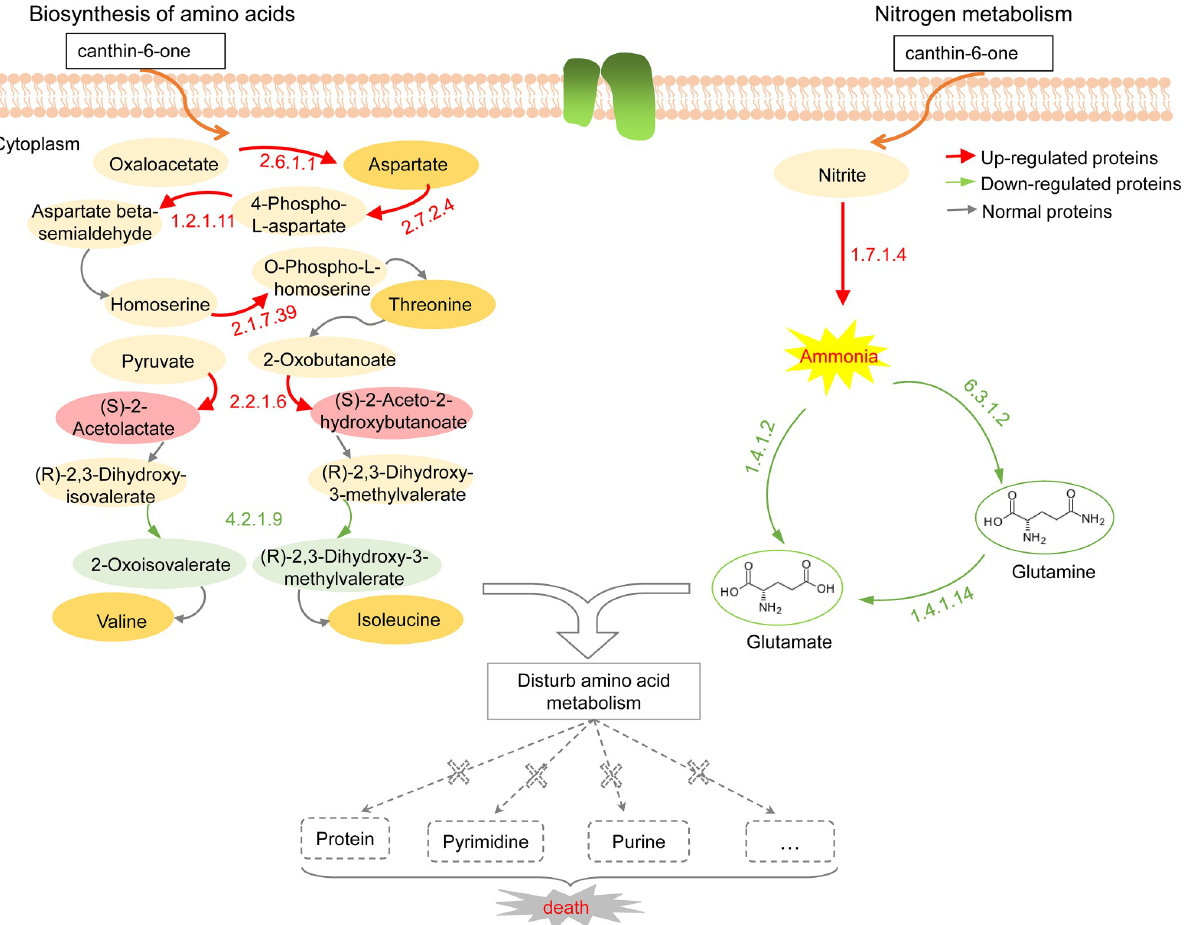
Fig 4. Schematic of amino acid biosynthesis and nitrogen metabolism pathways in response to canthin-6-one.